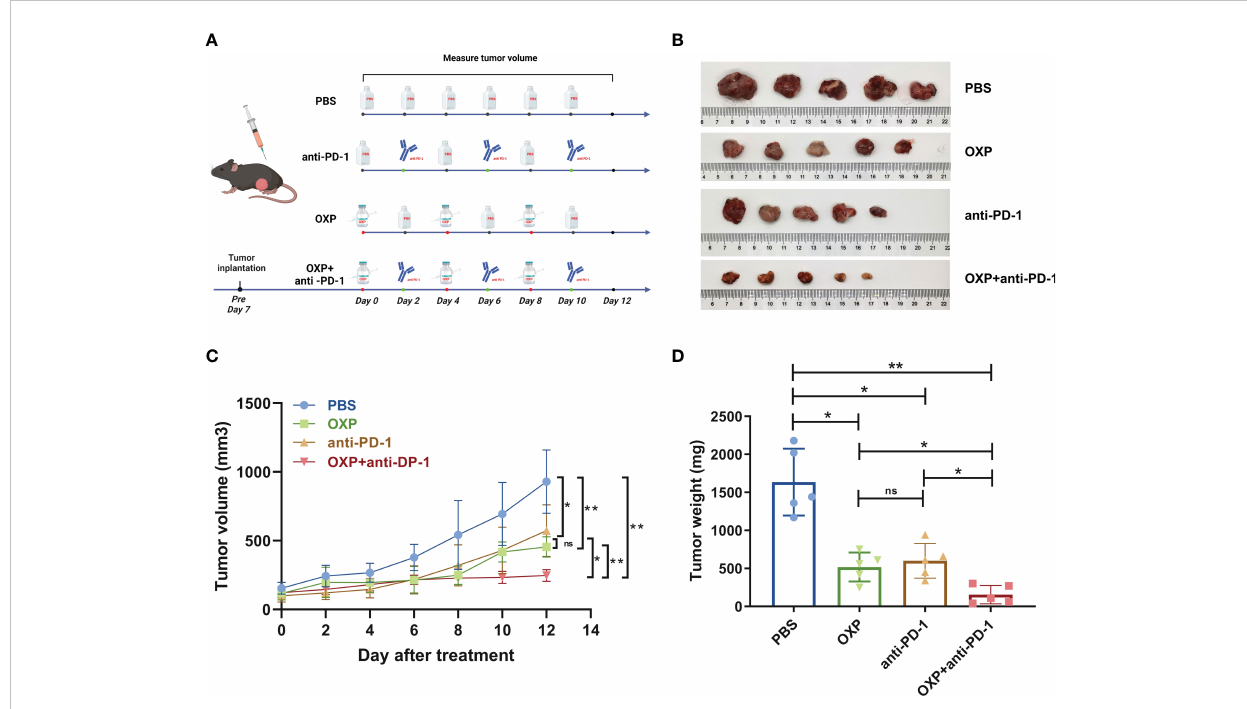
FIGURE 2 In vivo anti-tumor effect of combination OXP and anti-PD-1 inhibitor in C57BL/6 mice models bearing MB49 tumor (n = 5). (A) Experimental design and treatment process. (B) Excised tumor images. (C) Tumor growth curve. (D) Tumor weights of excised tumors. *P < 0.05; **P < 0.01; ns P >